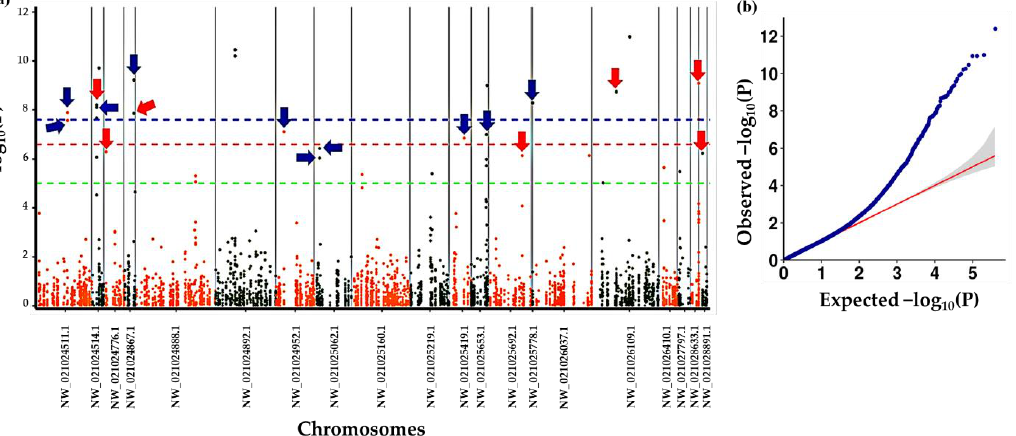
Figure 6. Manhattan plot ( a ) and quantile–quantile plot ( b ) for the altitude of 125 ancient plants. The abscissa represents scaffold position, and the ordinate represents p-value ( − log 10 (P)), with a negative logarithm (base 10). Scattered points (or lines) on the graph represent − log 10 (P) corresponding to each SNP loci. The green horizontal dashed line corresponds to − log 10 (P) = 5, the red horizontal dashed line corresponds to − log 10 (P) = 7, and the blue horizontal dashed line corresponds to − log 10 (P) =7.5. Red arrows indicate candidate gene loci obtained by screening, and blue arrows show the significant association signal peaks. Table 2. Strong association signal sites and annotation information of altitude. Chr Pos Gene ID − log 10 (P) Distance Allele NW_021024511.1 1773825